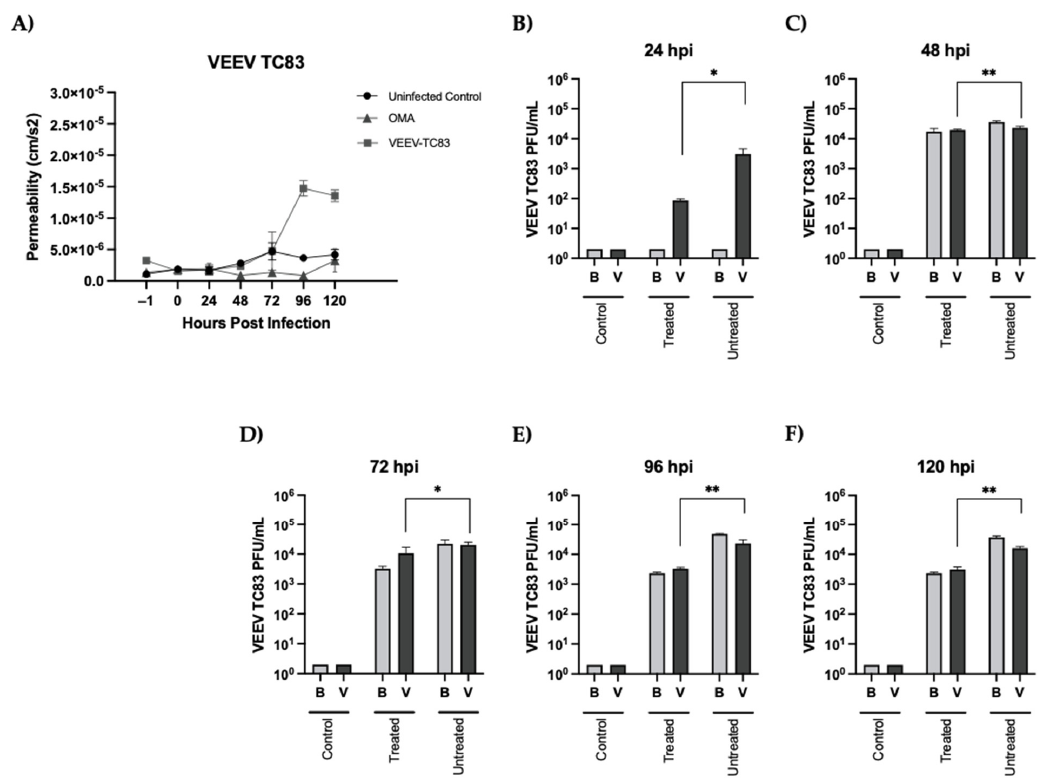
Figure 4. Impact of OMA treatment on BBB permeability and viral load in the brain and vascular compartments of the gNVU in the context of VEEV-TC83 infection. ( A ) Permeability of the endothelial layer of the gNVU was assessed by quantification of FITC-dextran levels in the brain and vascular chambers of the gNVU. Units were either infected with VEEV-TC83 and untreated or infected and treated with OMA. Control units refer to gNVUs that were neither infected nor treated with OMA. Data are obtained as averages from n = 3 each for infected, treated and infected, untreated sample, and n = 2 for control samples; ( B – F ) Longitudinal quantification of viral load in the brain (B) and vascular (V) sides of the NVU following infection by VEEV-TC83 (infected) and treatment with OMA (treated). Control refers to NVUs that were neither infected nor treated. Data are obtained as averages from n = 3 each for infected, treated and infected, untreated samples, and n = 2 for control samples, and infectious titers are represented as PFU/mL. Statistical analysis was performed using One-way ANOVA with Dunnett’s post-test. * p < 0.05, ** p <